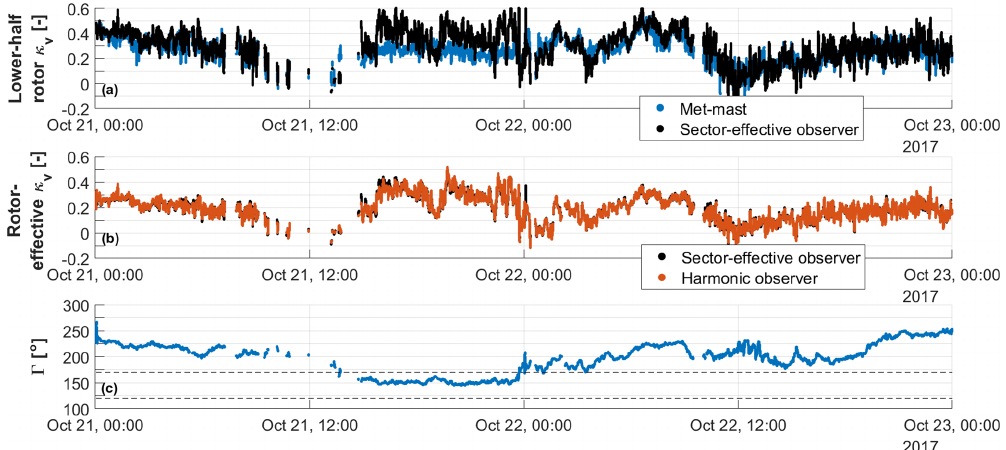
Figure 9. Time history of vertical shears at 10Hz. Lower-half-rotor shear from the met mast (blue) and the sector-effective observer (black) (a) ; full-rotor-equivalent shear using Eq. (9) (red) and reference from the sector-effective observer (black) (b) ; wind direction mea- sured at the met mast with WT1 in the wake of WT2 between 120 and 170 ◦ (dashed horizontal lines) (c)